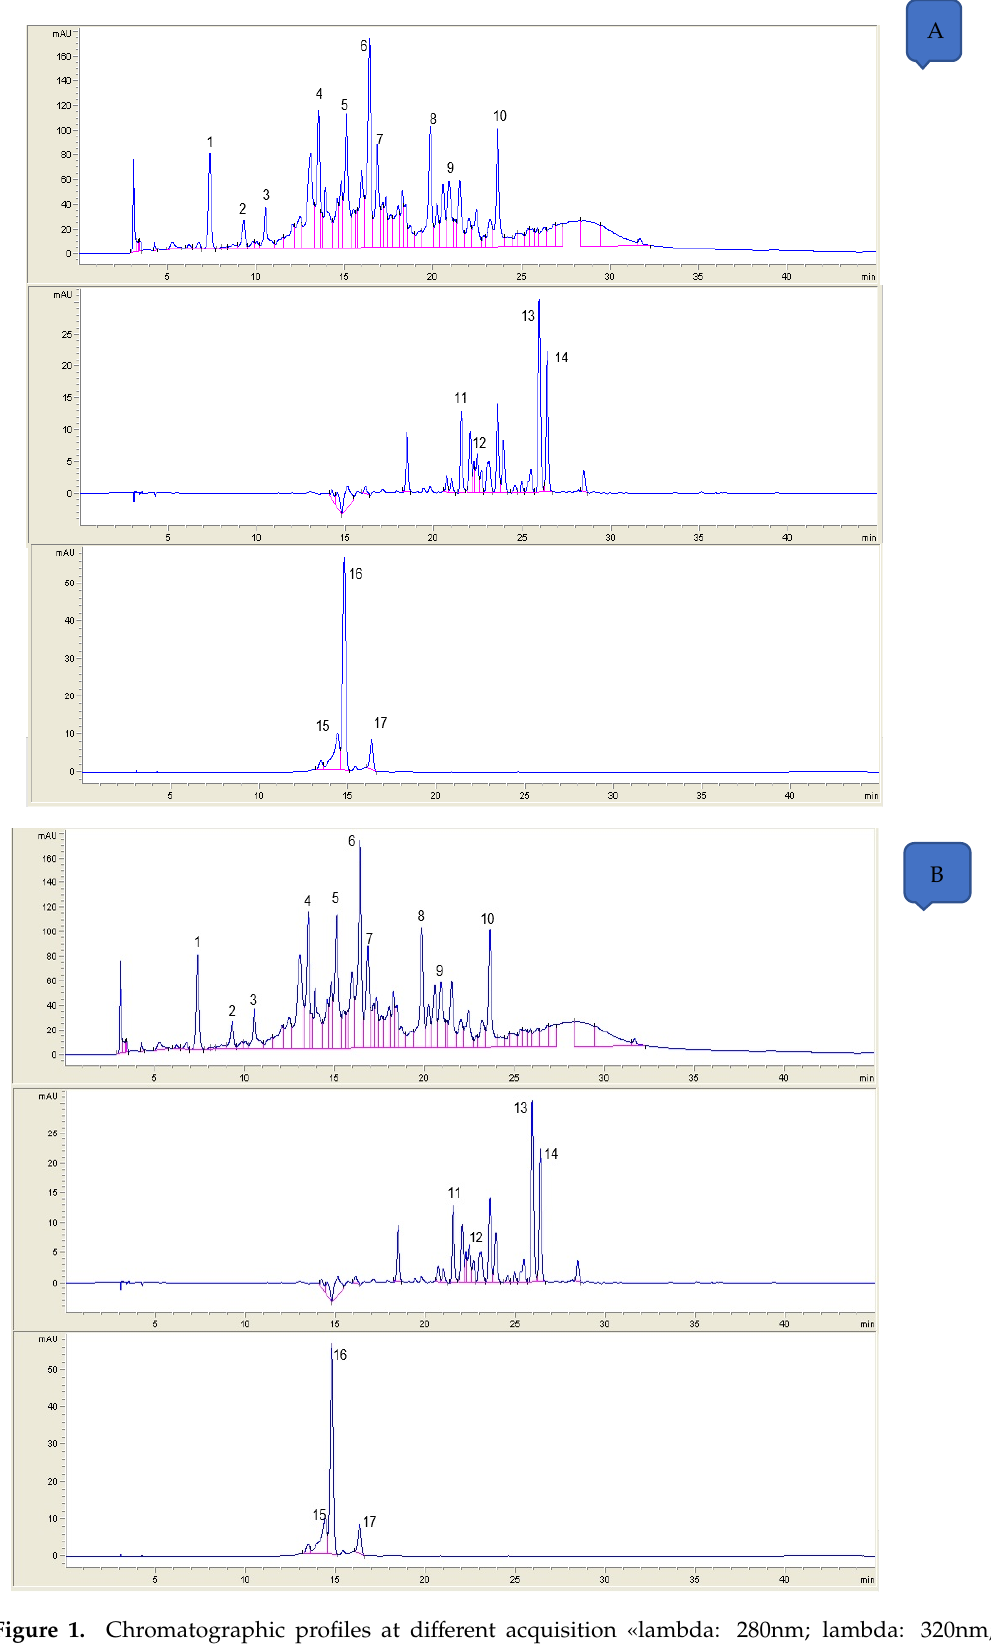
Figure 1. Chromatographic profiles at different acquisition «lambda: 280nm; lambda: 320nm; lambda: 360nm and lambda: 520 nm»: ( A ) MDZ strawberry genotype and ( B ) TAH strawberry genotype. Table 2. Peak number and wavelength of phenolic compounds.